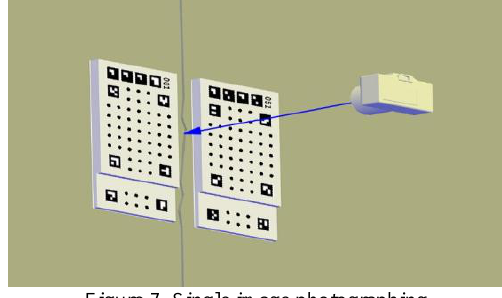
Figure 7. Single image photographing